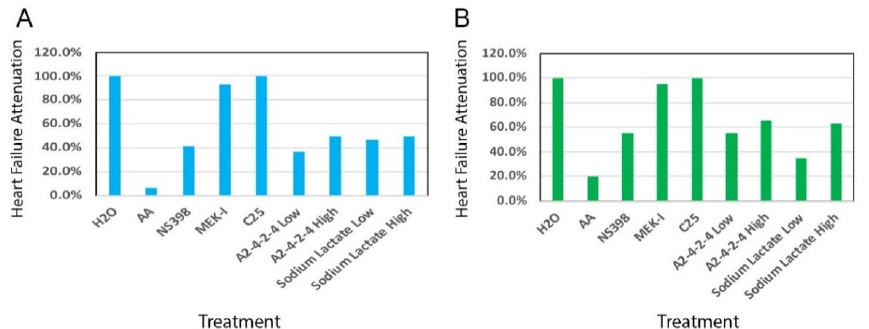
Figure 6. Sodium lactate attenuates AHF. AHF in zebrafish embryos was induced by ( A ) 10 µ M AA from 24–72 hpf or ( B ) 5 µ M AA from 24–96 hpf, as lower concentration AA takes a longer time to induce severe heart failure phenotypes. Sodium lactate was added to test its AHF attenuation ability at two concentrations (L, 1.5 mM; H, 15 mM). A2-4-2-4 was set up at two concentrations as well (L: 1:1000 dilution lactate; H: 1:300 dilution). Several positive compounds, NS398, MEK-I and C25, were set up for comparison.